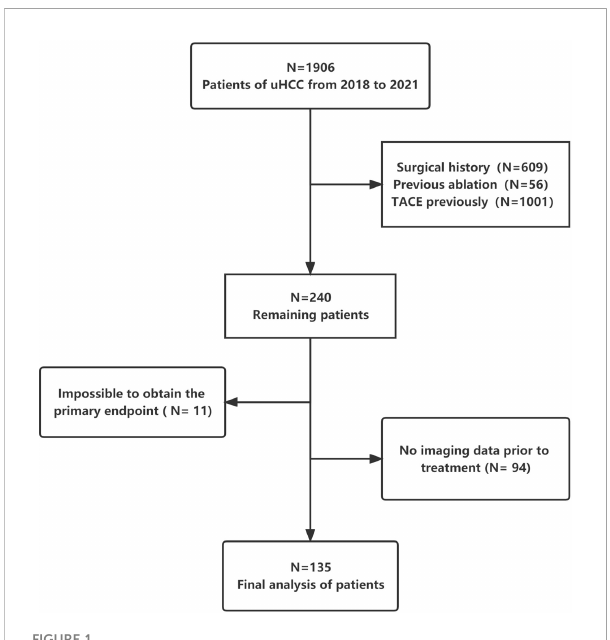
FIGURE 1 Flowchart demonstrating the patient inclusion